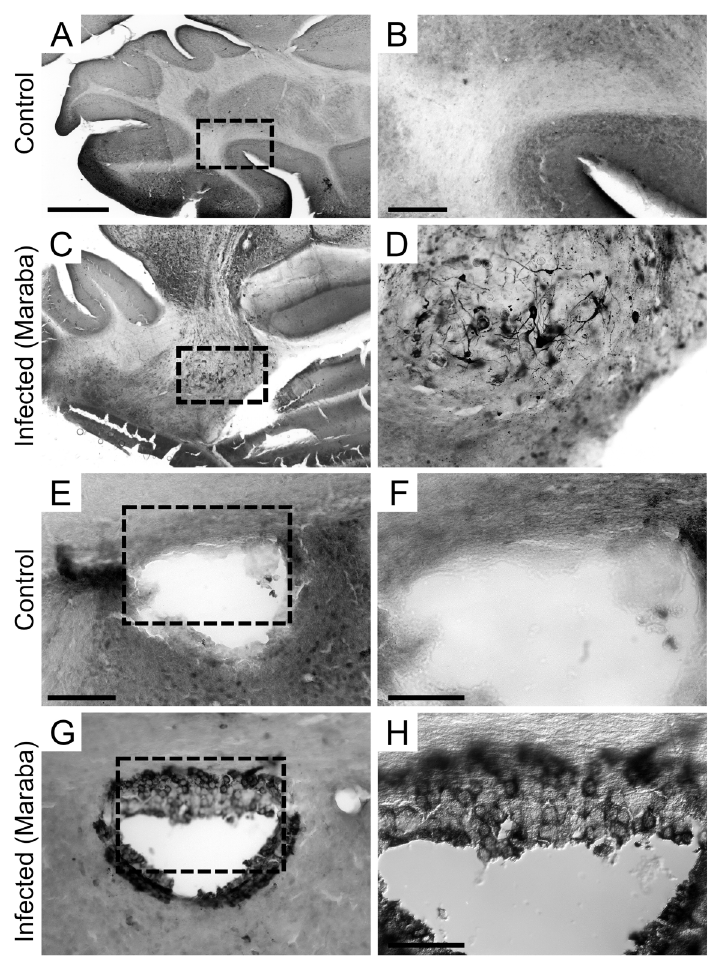
Figure 2. Photomicrographs of mouse brain sections immunolabelled for viral antigens. Control ( A , B , E , F ) and infected animals at 6 dpi (days post-infection) ( C , D , G , H ). Cerebellum from control ( A and B ) and infected mice ( C and D ); third ventricle wall from control ( E and F ) and infected mice ( G and H ). Dotted areas indicate areas of high-power images. Scale bars A , C : 650 m m; B , D : 150 m m; E , G : 50 m m; F , H : 30 m (Figure 3E and 3F), internal capsule, dentate gyrus, basal ganglia, thalamus, cingulum, callosal fi bers, brainstem, cerebellum (Figure 2C and D), and brain meninges.